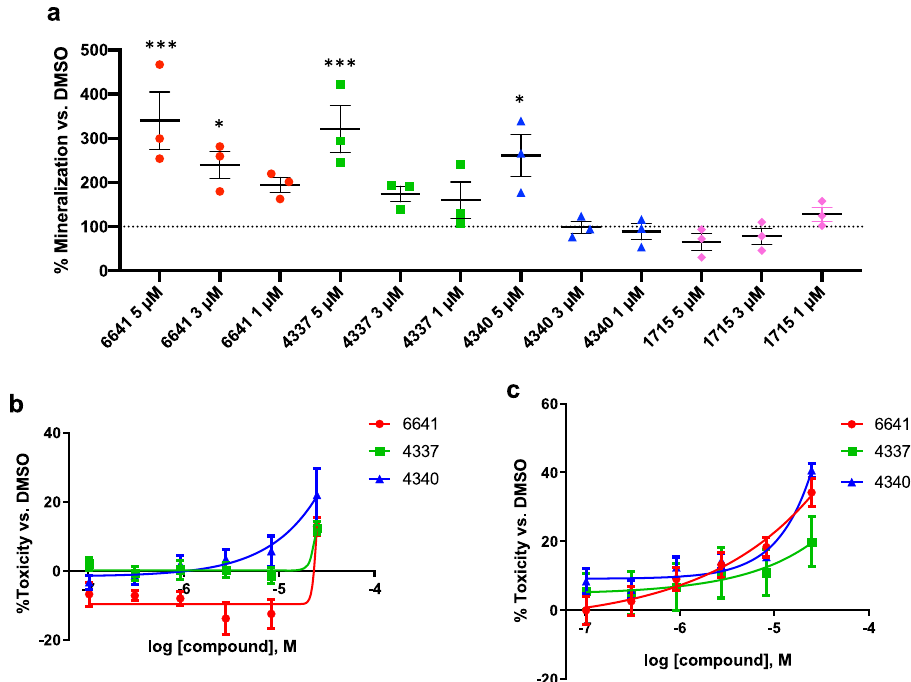
Fig. 4 RXFP2 agonists induce mineralization of primary human osteoblasts and are non-cytotoxic. a Mineral hydroxyapatite fl uorescent quanti fi cation after 14-day treatment in HCO cells. Results were normalized to control DMSO as 100% mineralization. b HCO and c HAVSMC toxicity after 24-h treatment with RXFP2 agonists, normalized to DMSO treatment as 0% toxicity. Results are expressed as mean ± SEM of 3 independent experiments. * p < 0.05, *** p < 0.001 vs. DMSO using One-way